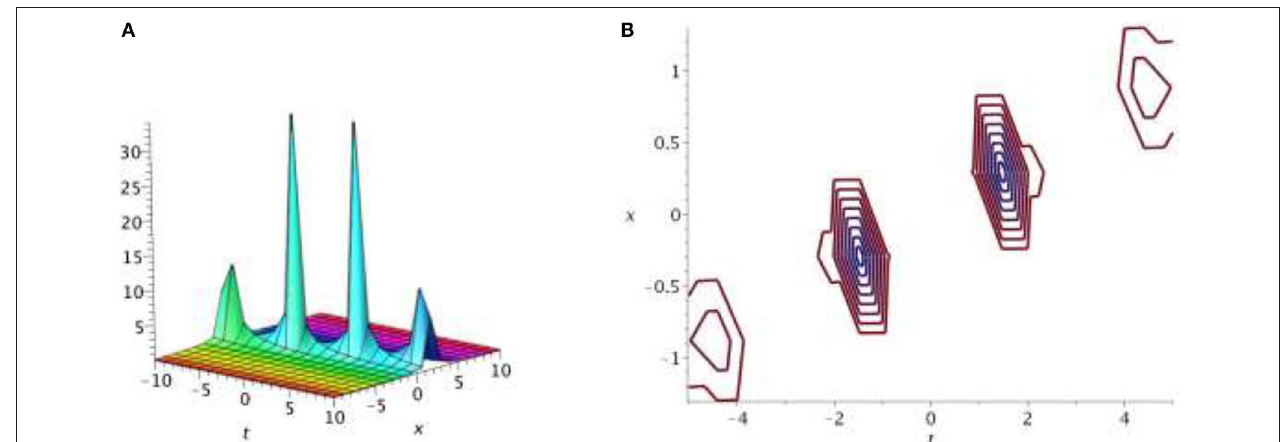
FIGURE 3 | (A) Singular solution Equation (43). (B) Contour plot.